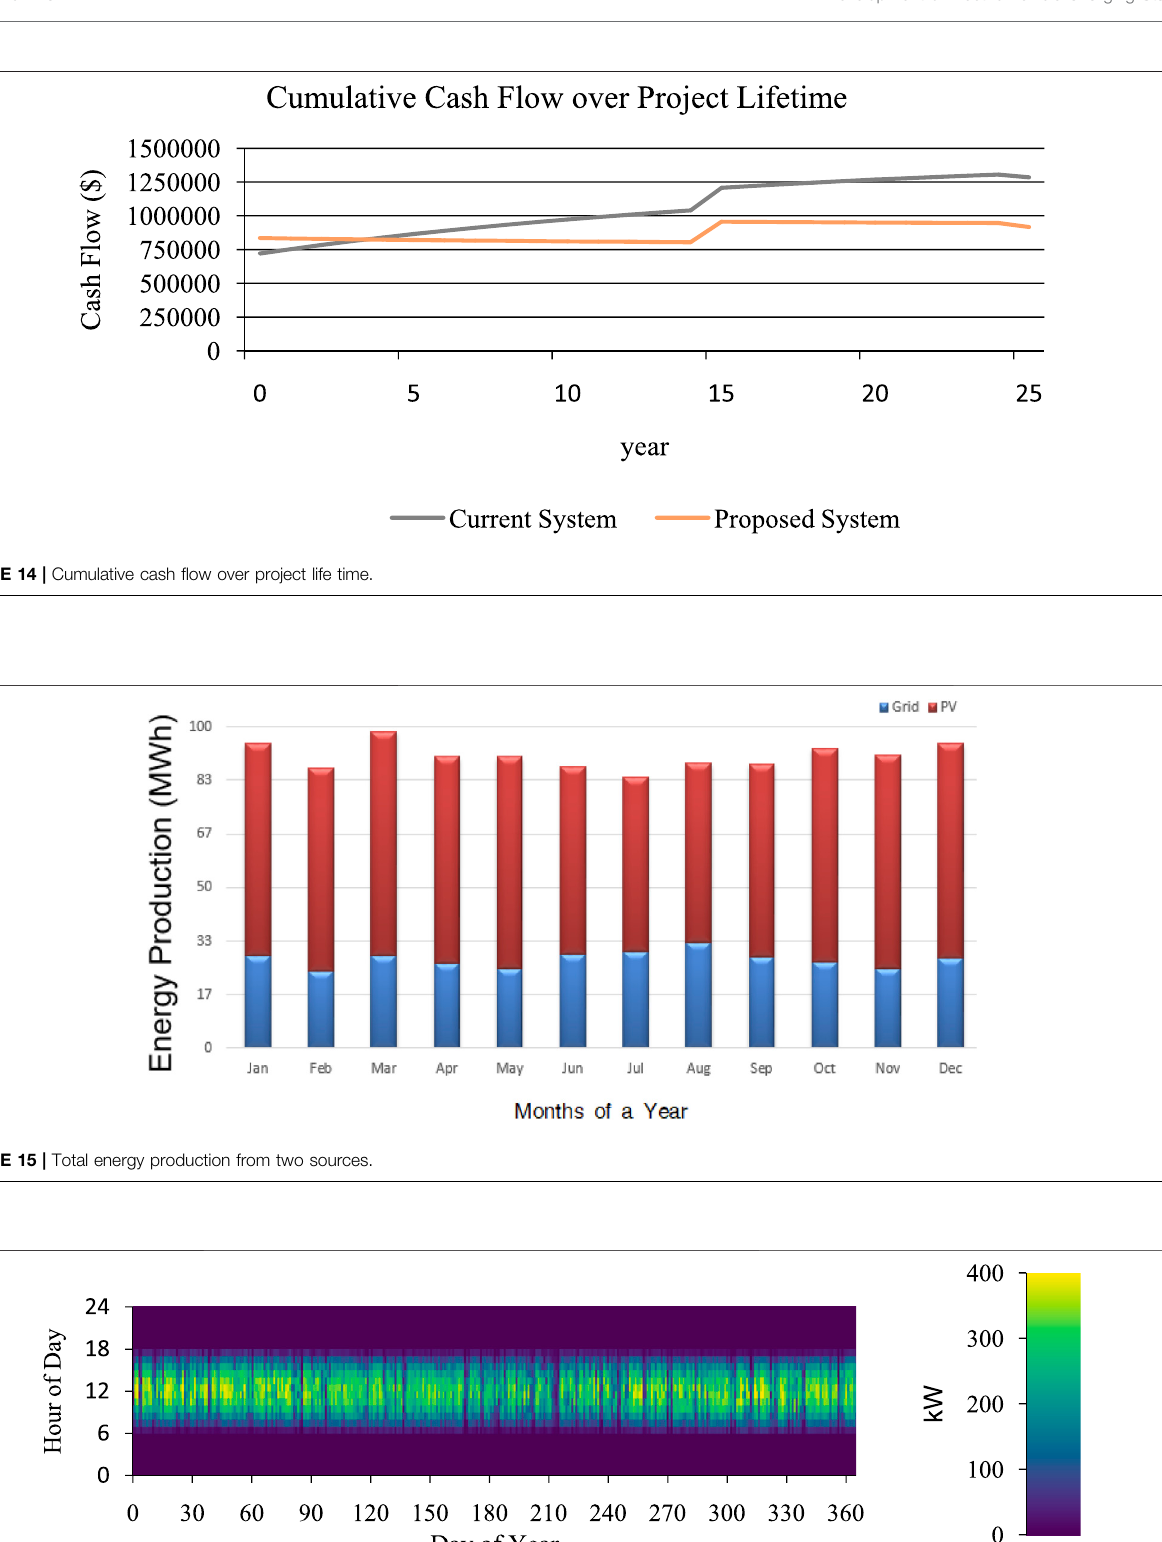
FIGURE 16 | Power production from solar PV system.